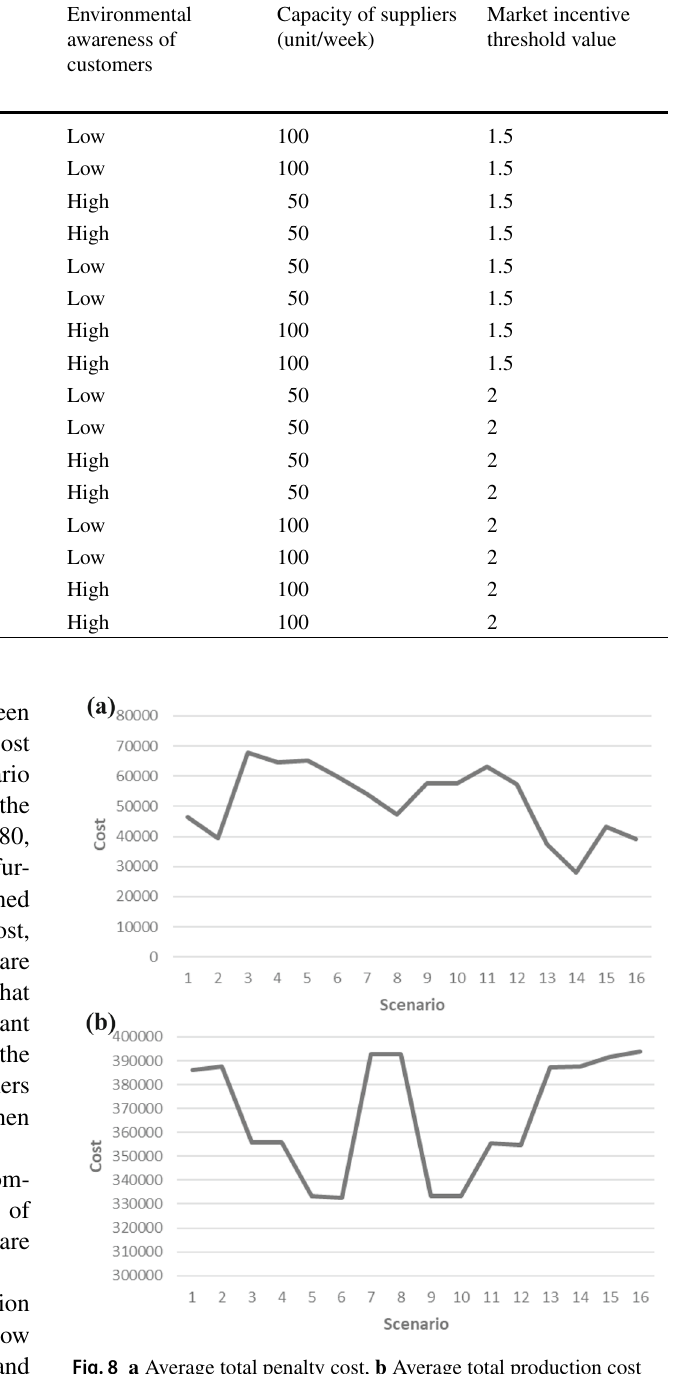
Table 2 Developed scenarios for analyzing the behavior of the model